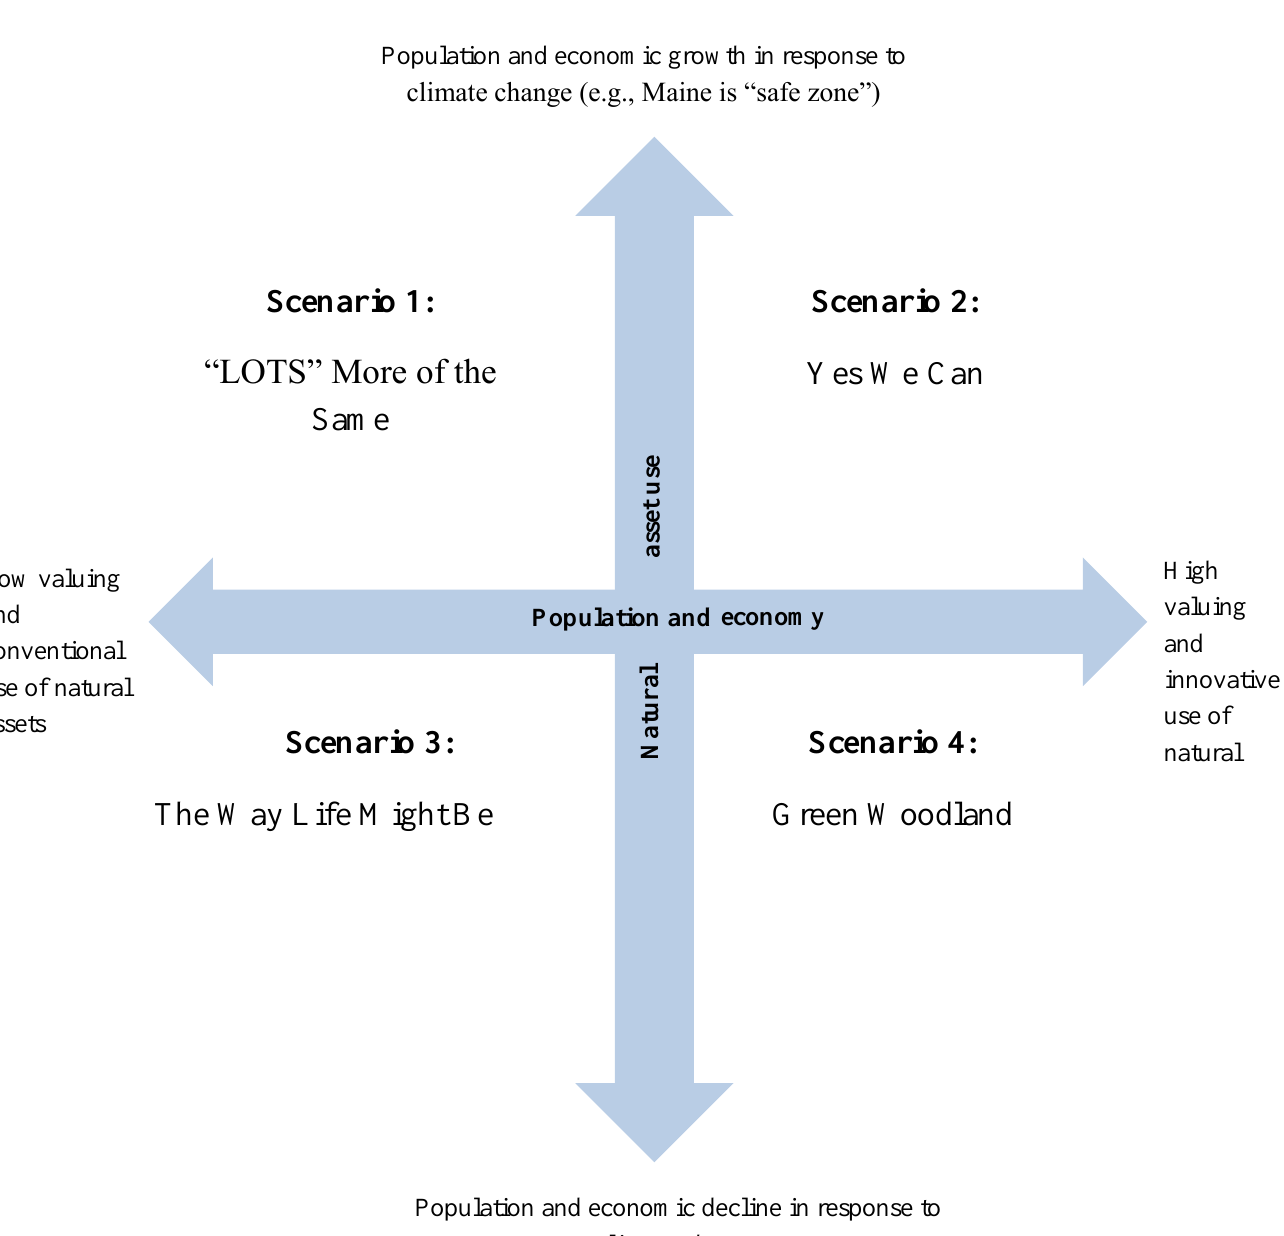
Fig. A2.3. Maine scenario